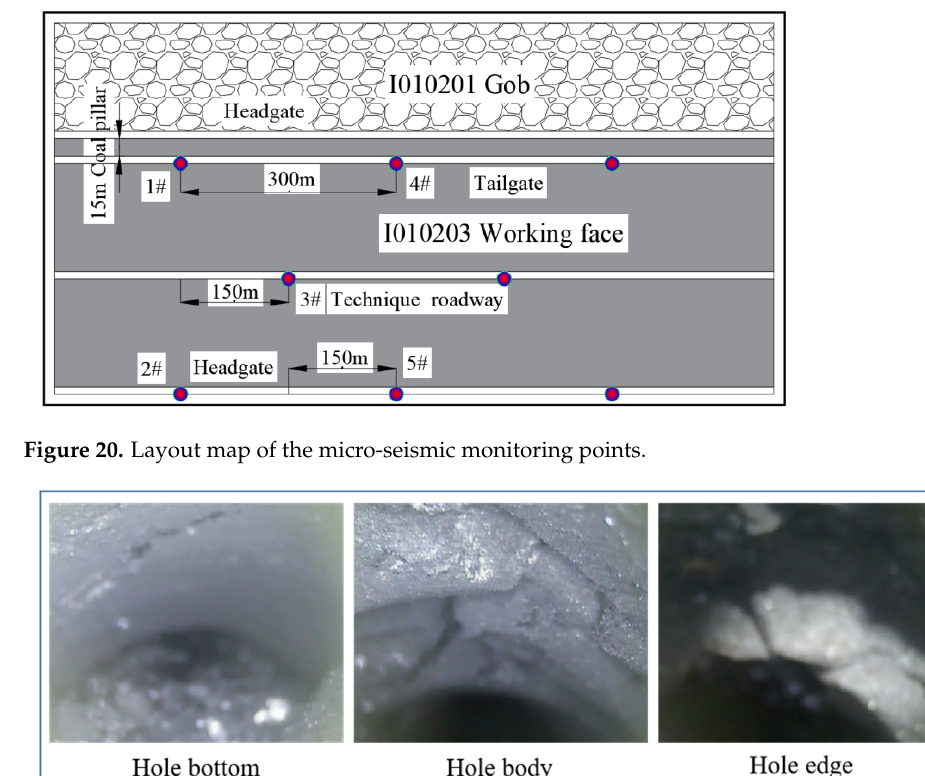
Figure 20. Layout map of the micro-seismic monitoring points.